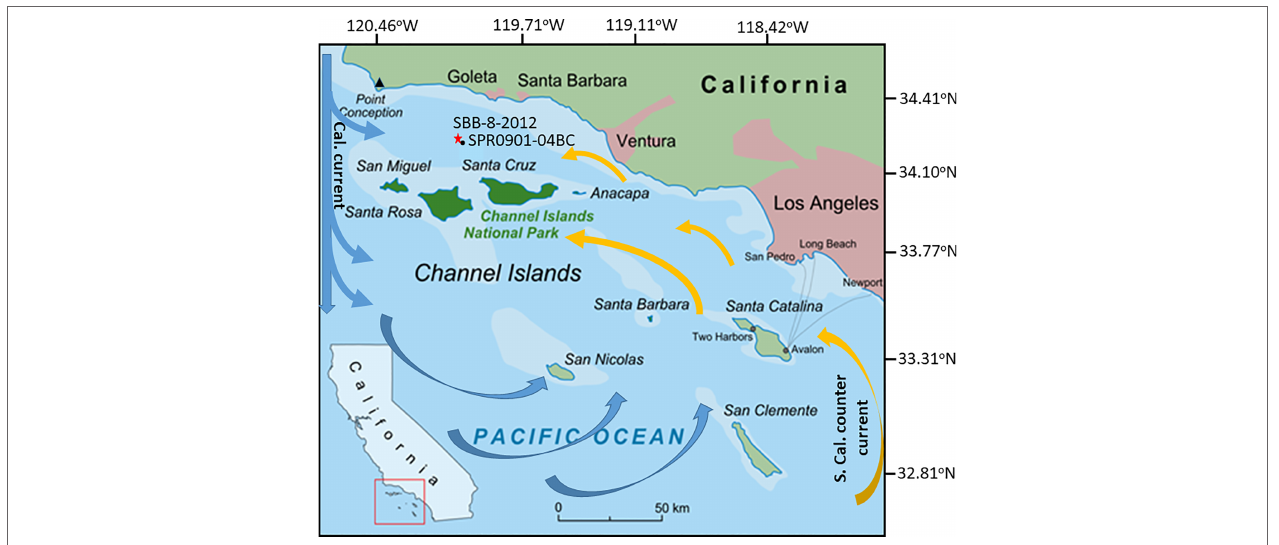
FIGURE 1 | Location map of the study area. The red star shows the location of core SBB-8-2012 site in Santa Barbara Basin and the black dot indicates core SPR0901-04BC location of Hendy et al. (2015). Blue arrows present cold and nutrient-rich current from north, whereas the orange arrows reflect warm and nutrient- depleted current from